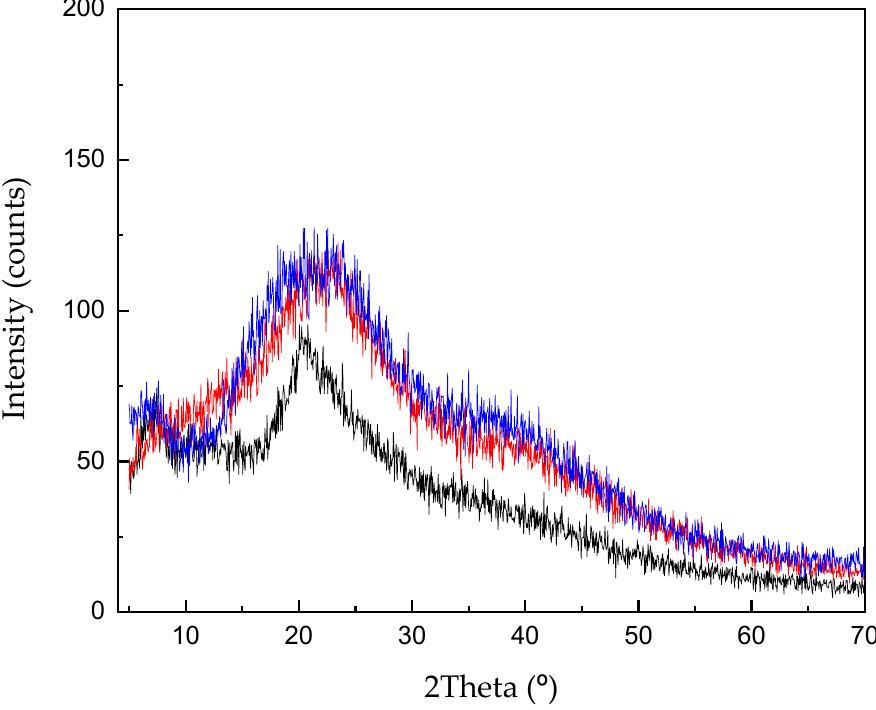
Figure 2. XRD diffraction pattern of the membranes obtained out of: Carboxymethyl Chitosan derivative (CMC)/extract 3:2 (red line); CMC/water 3:2 (black line); Extract alone (blue